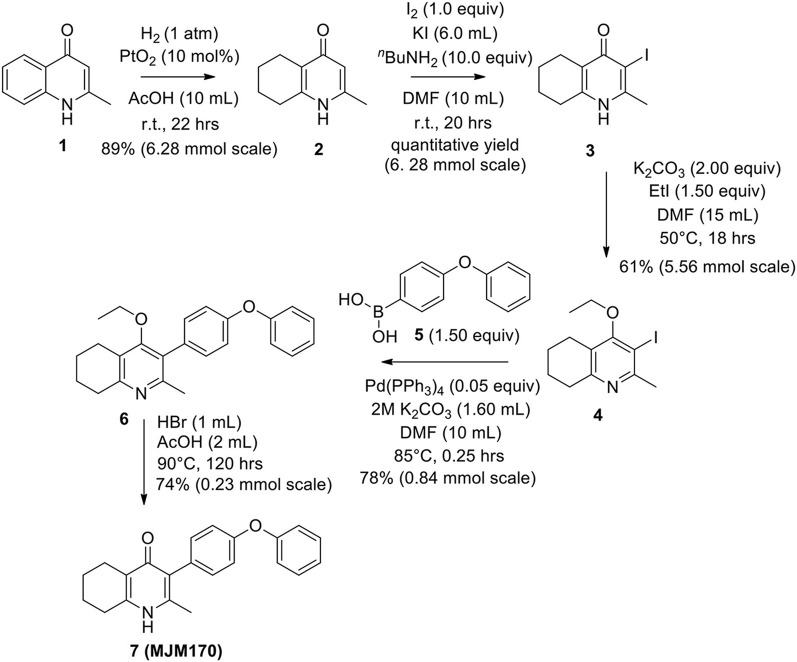
Synthesis of hit compound 7, also known as MJM170 (McPhillie et al., 2016). Synthetic scheme inspired by the route to endochin-like quinolones (ELQs) reported by Doggett et al. (2012).